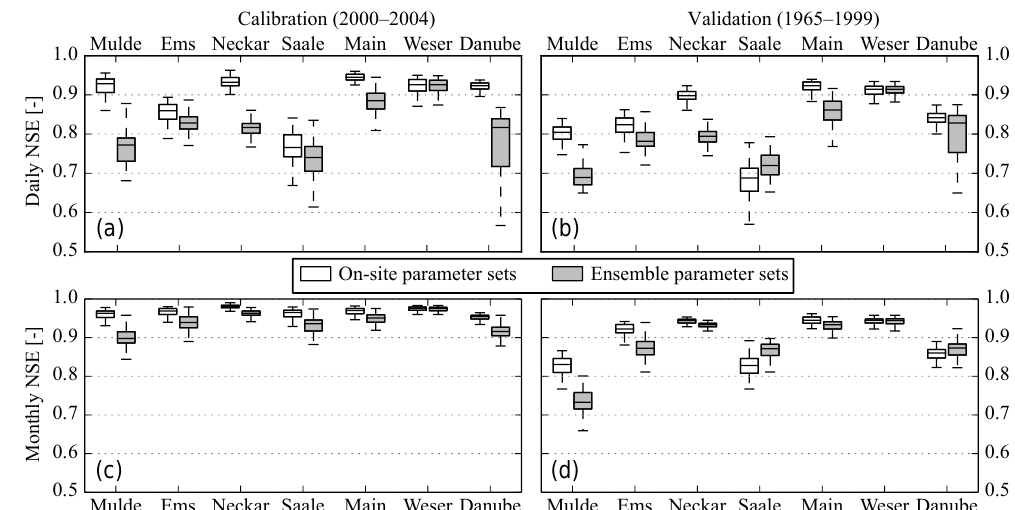
Figure 2. Model performance expressed as Nash–Sutcliffe efficiency (NSE) at daily (a, b) and monthly (c, d) resolutions for the calibration period 2000–2004 (a, c) and validation period 1965–1999 (b, d) . The white box plots show the results of the on-site calibration, whereas the gray box plots are simulations using the 100 ensemble parameter sets for Germany. Please note that the y axis starts at NSE = 0.5.